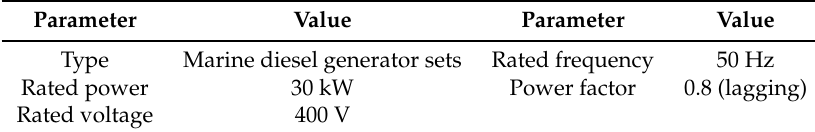
Table 2. Main parameters of the generator.